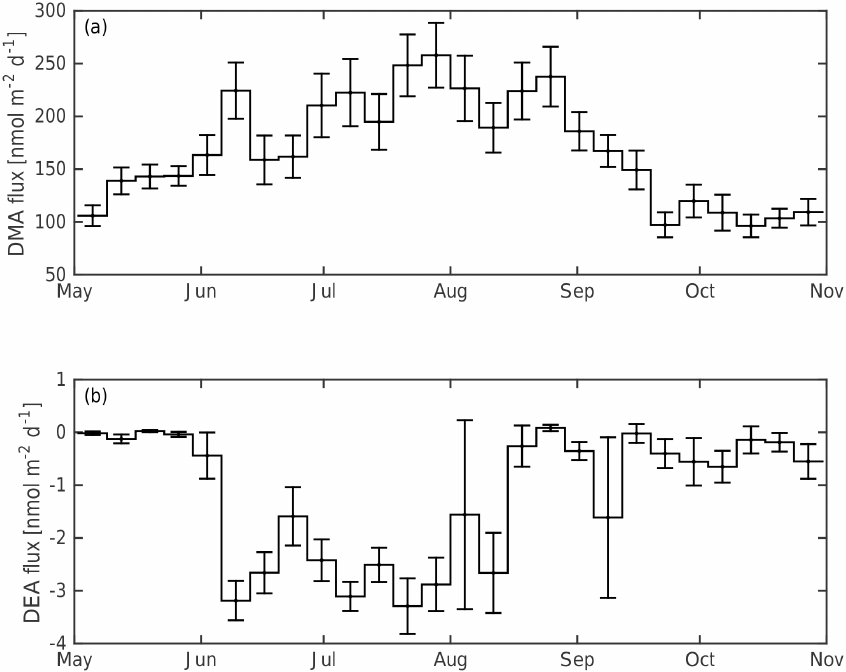
Figure 5. Weekly averages of estimated fluxes of dimethylamine (DMA, a ) and diethylamine (DEA, b ) and their standard deviations from May 2011 to October 2011. In emission estimation constant soil solution pH5.3, average soil depth of 0.05m, and constant soil solution concentrations of DMA and DEA (92.3 and 0.296µmolL − 1 , respectively) were